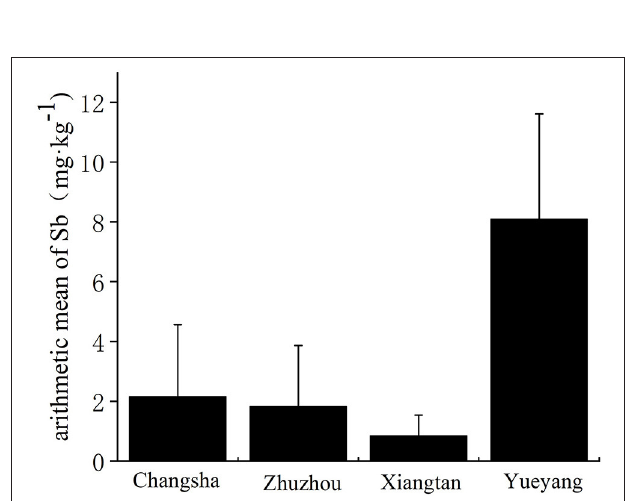
FIGURE 3 | The content of Sb on the surface layer of paddy soil of different cities.